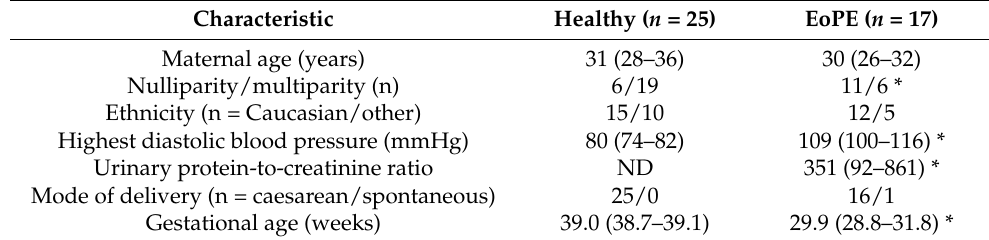
Table 1. Clinical characteristics of